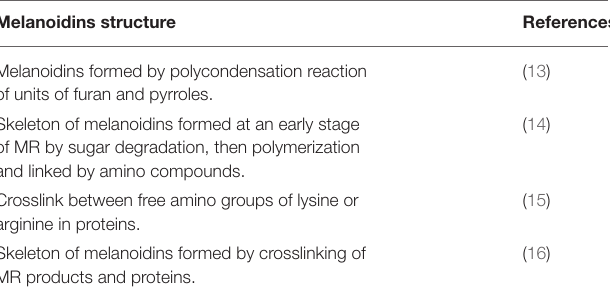
TABLE 1 | The proposed chemical structures of melanoidins. Melanoidins